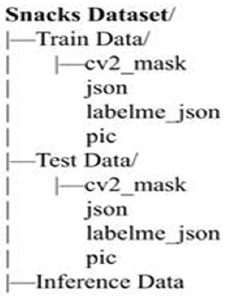
Figure 9. Format for the Snacks dataset.